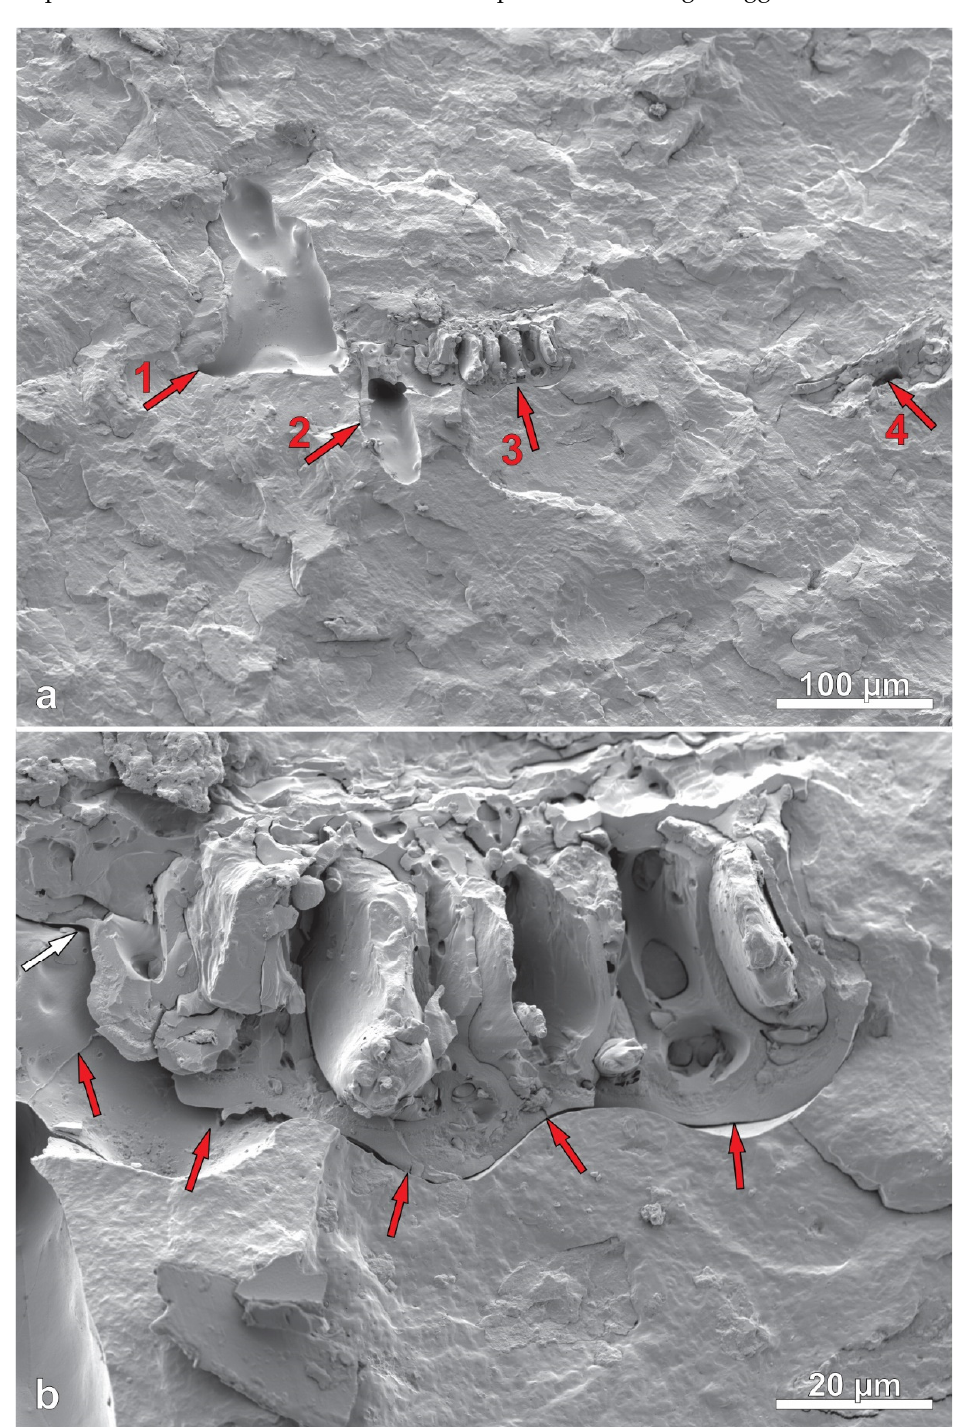
Figure 12. Images of cryo-fractured TRH composite. Image (a) has 4 numbered arrows (in red): (1) shallow hole left from TRH particle, (2) deeper hole left from TRH particle, (3) TRH particle, and (4) shallow hole from TRH particle. Red arrows on image (b) shows space between particle and matrix, indicating poor adhesion.